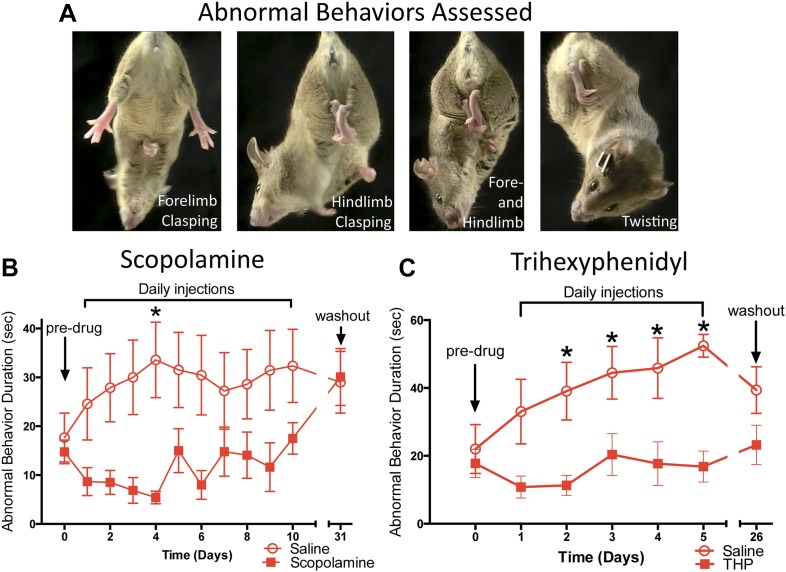
Antimuscarinic drugs ameliorate clasping and twisting behaviors in Dlx-CKO mice.(A) Examples of forelimb clasping, hindlimb clasping, and trunk twisting that were evaluated during review of the videos by blinded raters. (B) Duration of clasping and twisting was significantly reduced by once-daily 5 mg/kg scopolamine administration (tail suspension recorded 45 min following drug treatment; two-way ANOVA: main effect of drug F1,141 = 36.14; p < 0.0001, Sidak's multiple comparisons test. n = 8 saline, n = 6 scopolamine. This study was also repeated in a second cohort). (C) Clasping and twisting duration was reduced by once-daily 5 mg/kg THP administration compared to saline-treated mice (tail suspension recorded 45 min following drug treatment; two-way ANOVA main effect of drug F1,82 = 46.69, p < 0.0001, Sidak's multiple comparison test. n = 6 saline, n = 8 THP).